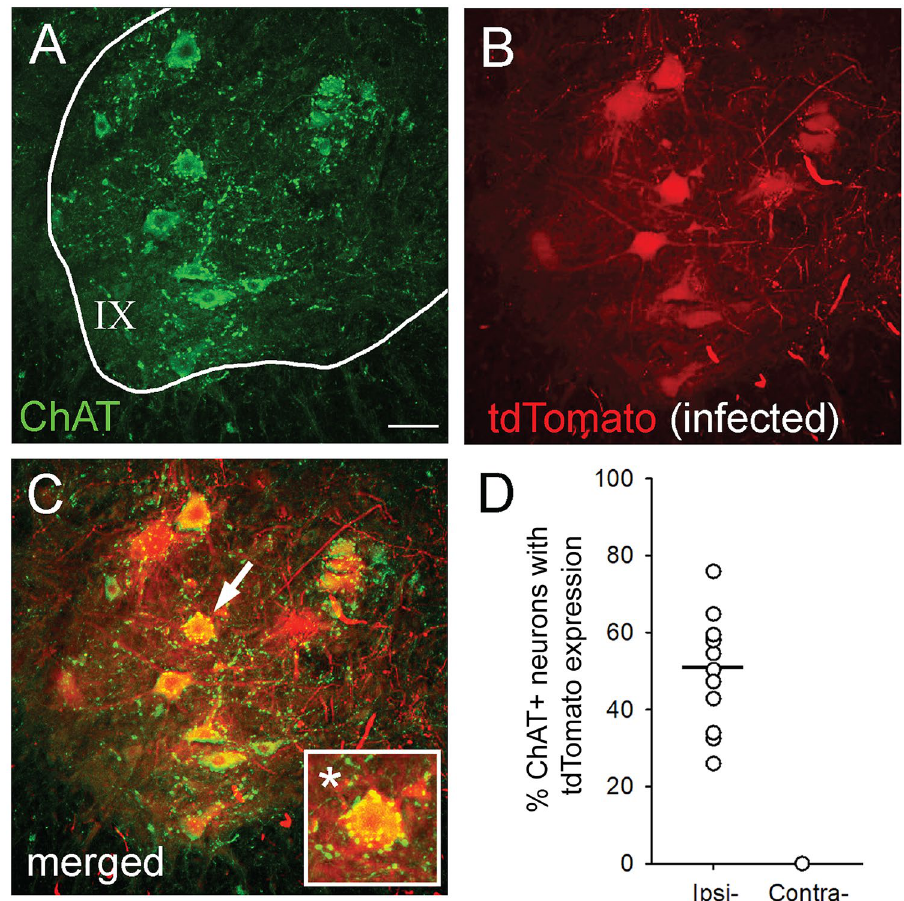
Figure 3. Intramuscular injection of AAV9CMVCre leads to expression of tdTomato in ventral spinal cord motor neurons. ( A ) ChAT positive motor neurons within lamina IX of the spinal cord. ( B ) AAV9CMVCre transfected motor neurons expressing tdTomato. ( C ) Merged image of ( A ) and ( B ) shows colocalization of ChAT positive neurons and tdTomato expression (arrow shows inset *). ( D ) The percentage of ChAT labelled motor neuron expressing tdTomato in the ventral horn of the spinal cord. AAV9CMVCre intramuscular injection tranfects 51.2% of ChAT-positive neurons in lamina IX on the ipsilateral injected side (Ipsi-). On the contralateral side (Contra-) there was no co-labelling between ChAT motor neurons and tdTomato expression. Data shown as scatterplot with mean. Scale bar in ( A ) = 50 µm and applies to images in ( B ) and ( C